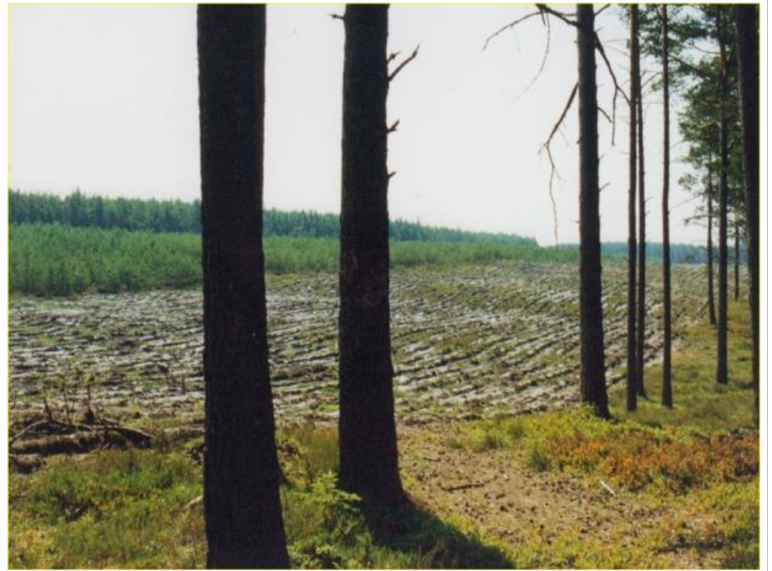
Figure 1. A clearcutting silvicultural system produces even-aged forest stands (a result of artificial regeneration) of regular shape. A gradation of stand ages from felling at different times is seen, from a mature forest (right) to a recently harvested and planted area, an area of young regenerated trees, and a forest stand approaching canopy closure (left) (photo: Z.